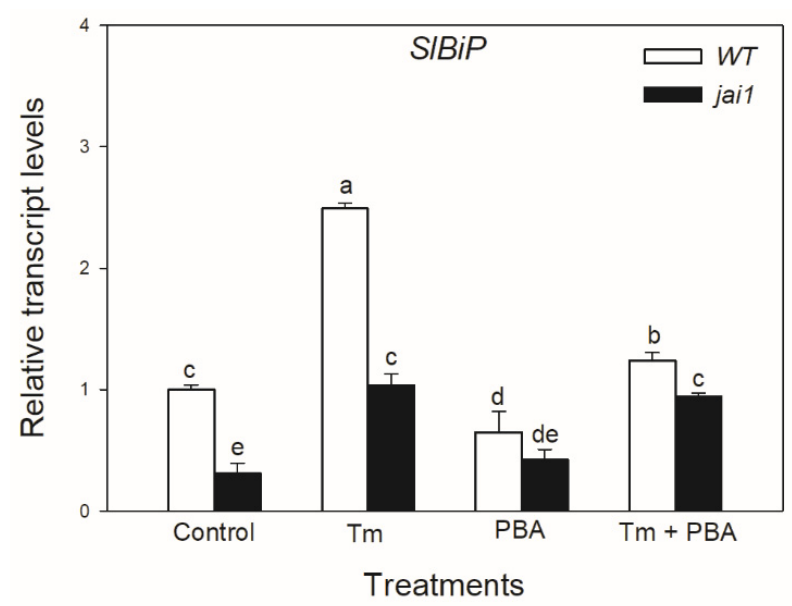
Figure 4. Changes in the transcript accumulation of SlBiP in the leaves of wild-type (WT) and JA signalling mutant (jai1) tomato plants exposed to 5 µ g mL − 1 tunicamycin (Tm), 1 mM 4-phenylbutyrate (PBA), and Tm + PBA for 6 h. Results are the mean ± SE. Data with di ff erent letters indicate significant di ff erences at p < 0.05 level, n =